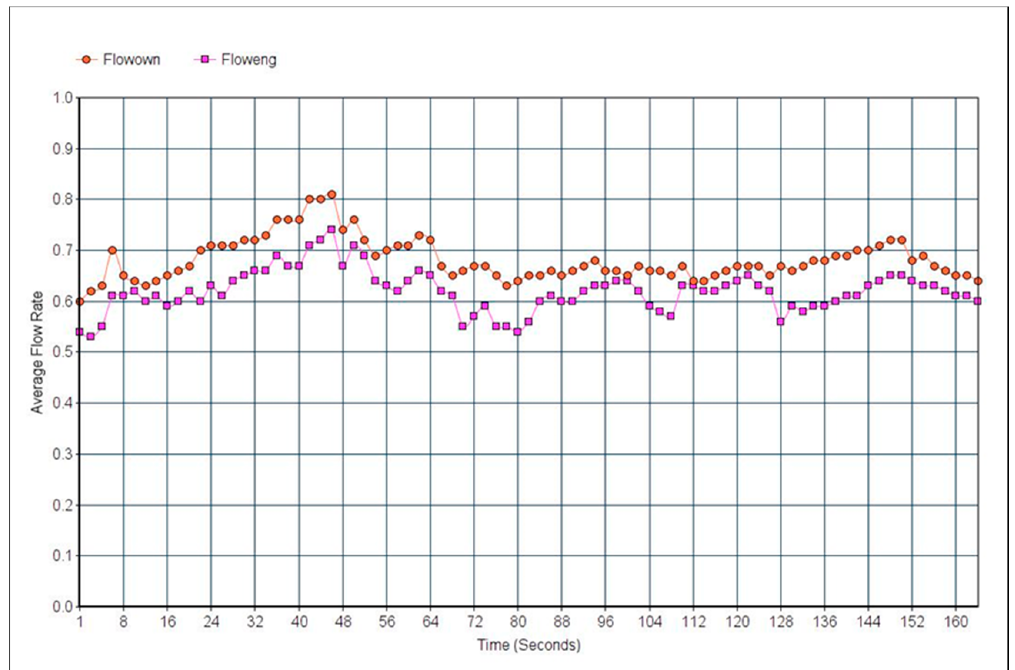
Figure 6. Average flow ( Flowown ) and reception flow ( Floweng ) rates in normal conditions.